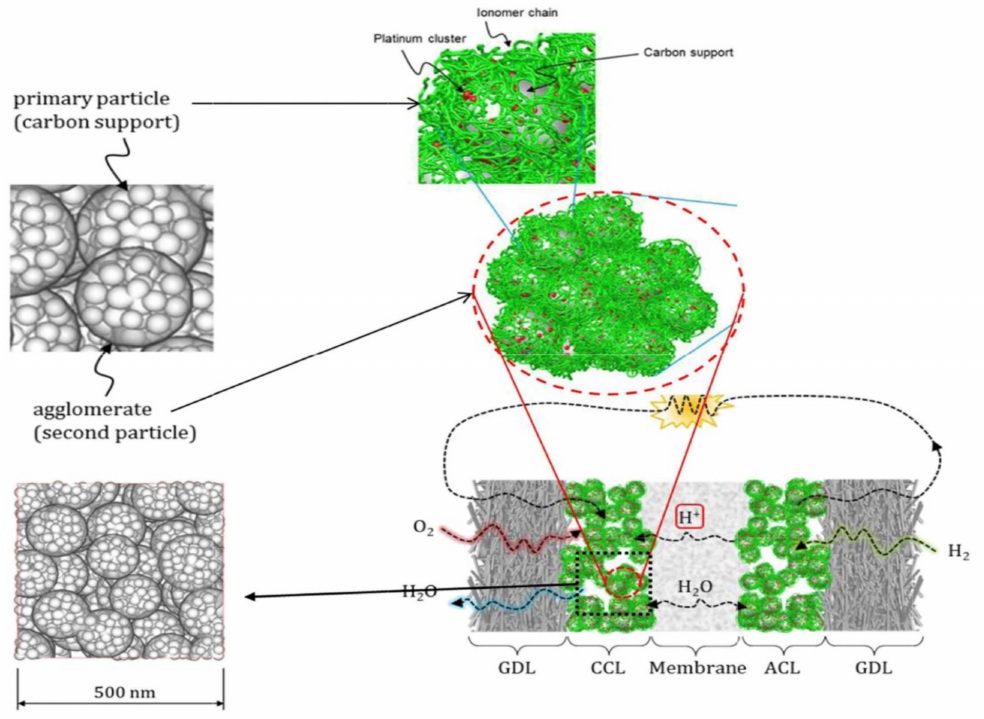
Figure 3. Schematic diagram of CL composition [21]. Copyright 2017